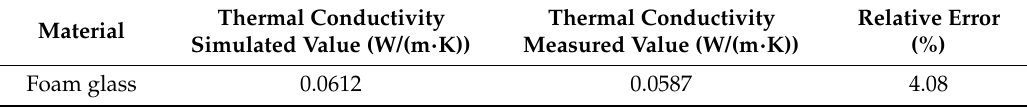
Table 5. Comparison of simulated and measured values of thermal conductivity of foam glass.